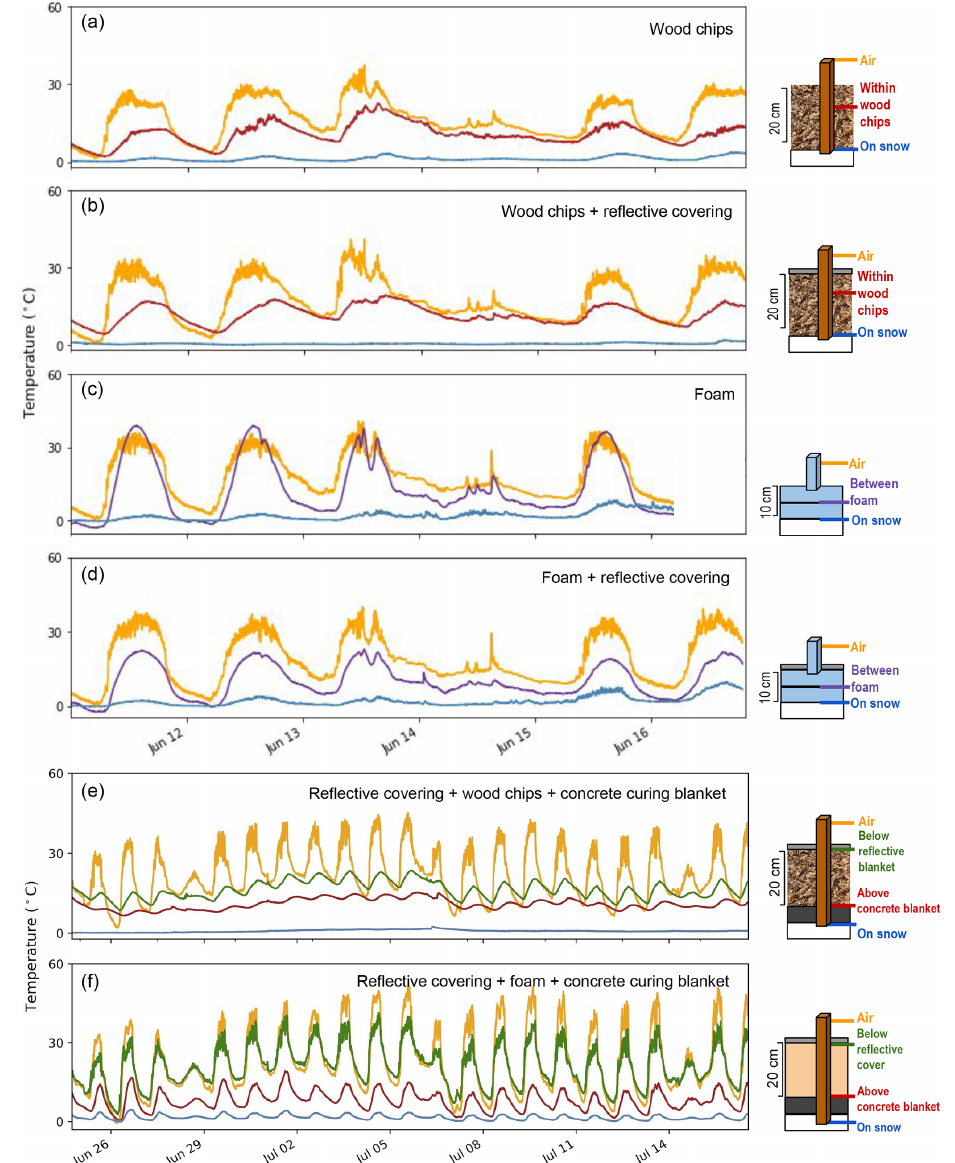
Figure 4. Cover experiments and resulting temperature records. (a) Site 1 – woodchips. (b) Site 1 – woodchips overlain by reflective cover. (c) Site 1 – foam. (d) Site 1 – foam overlain by reflective cover. (e) Site 2 – woodchips underlain by concrete curing blanket and overlain by reflective cover. (f) Site 2 – open-cell foam underlain by concrete curing blanket and overlain by reflective